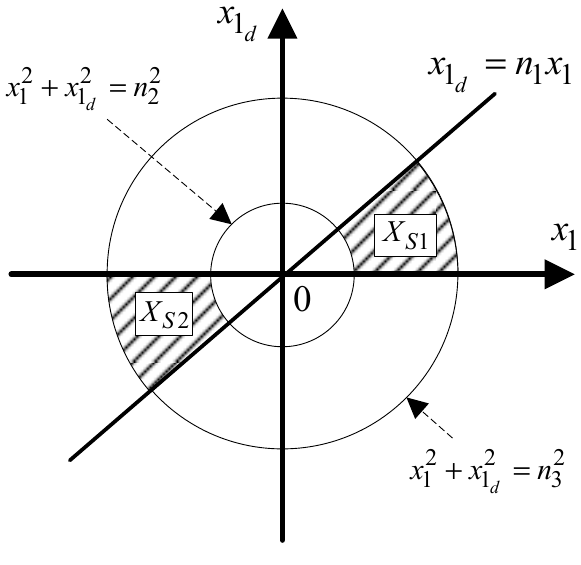
Figure 2. X s 1 and X s 2 for n d